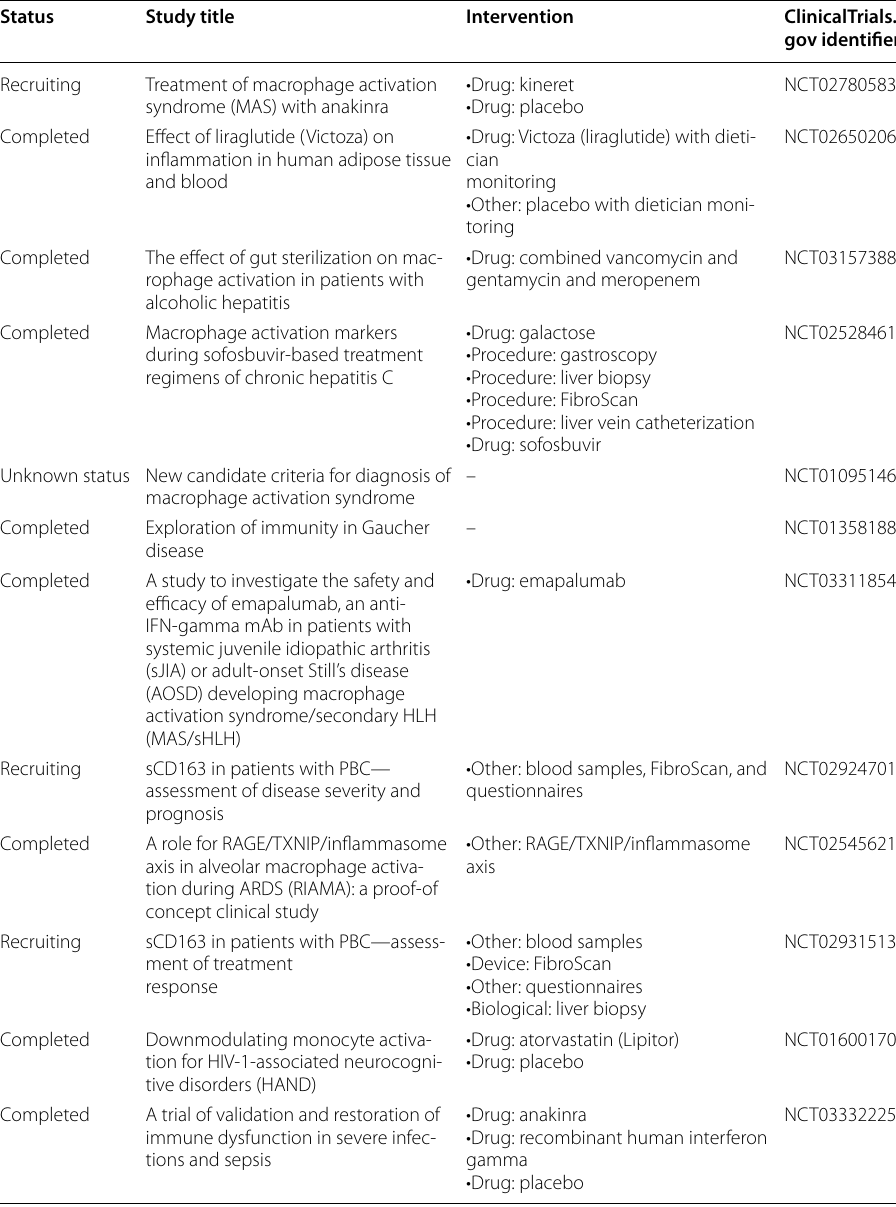
Table 3 Clinical trials on macrophage polarization and